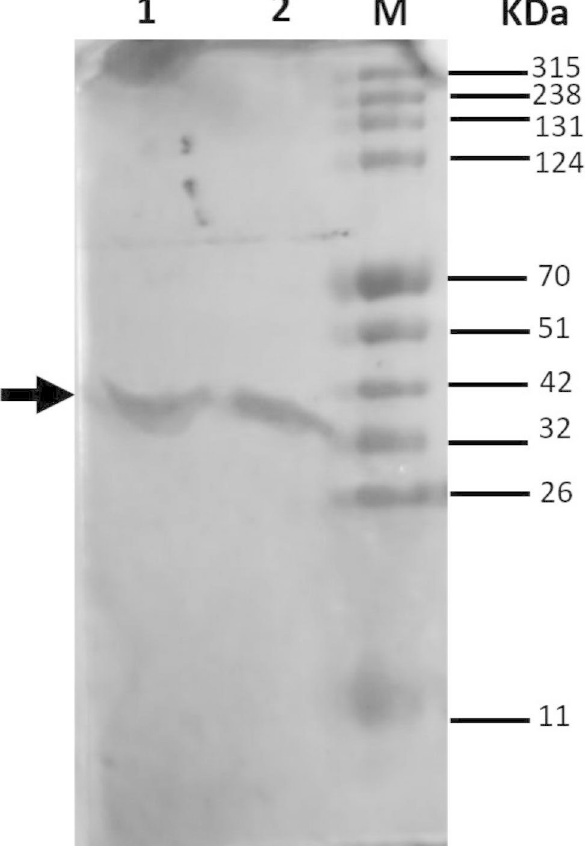
Fig. 3 SDS-PAGE (10%) showing the recombinant expressed AXE-HAS10 during the stages of purification using Ni 2+ -affinity agarose matrix.: Lane M: protein ladder in kDa. Lanes 1 & 2 purified AXE-HAS10 after elution from the Ni 2+ -affinity agarose matrix column using the elution buffer (50 mM Tris- HCl, pH 8.0, 500 mM imidazole) indicated by a sold arrow